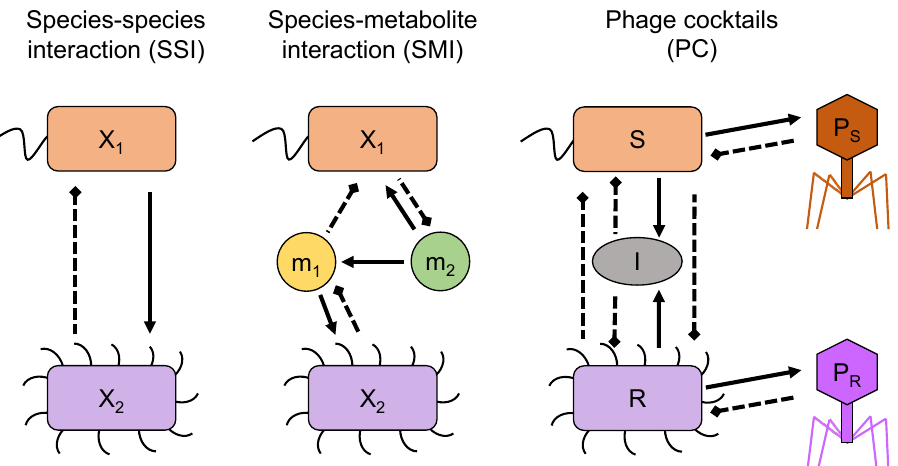
Figure 1. The three main classes of microbial community models analysed in this paper. Positive interactions (i.e., which increase the abundance of the entity to which they point) are represented by solid arrows, while negative interactions (which decrease the abundance of the target) are represented by dashed lines with a square end. SSI models (left) describe the dynamics as direct competition or cooperation between species (depicted as two different bacteria). SMI models (central panel) describe the dynamics as the result of competition for resources. In the diagram, bacterium X 1 consumes metabolite m 2 , while X 2 consumes m 1 ; furthermore, m 2 can also be transformed into m 1 , which is a by-product detrimental to X 1 . The panel on the right depicts a phage cocktail (PC) in which each phage ( P S , P R ) attacks a specific bacterium; the immune response I is also